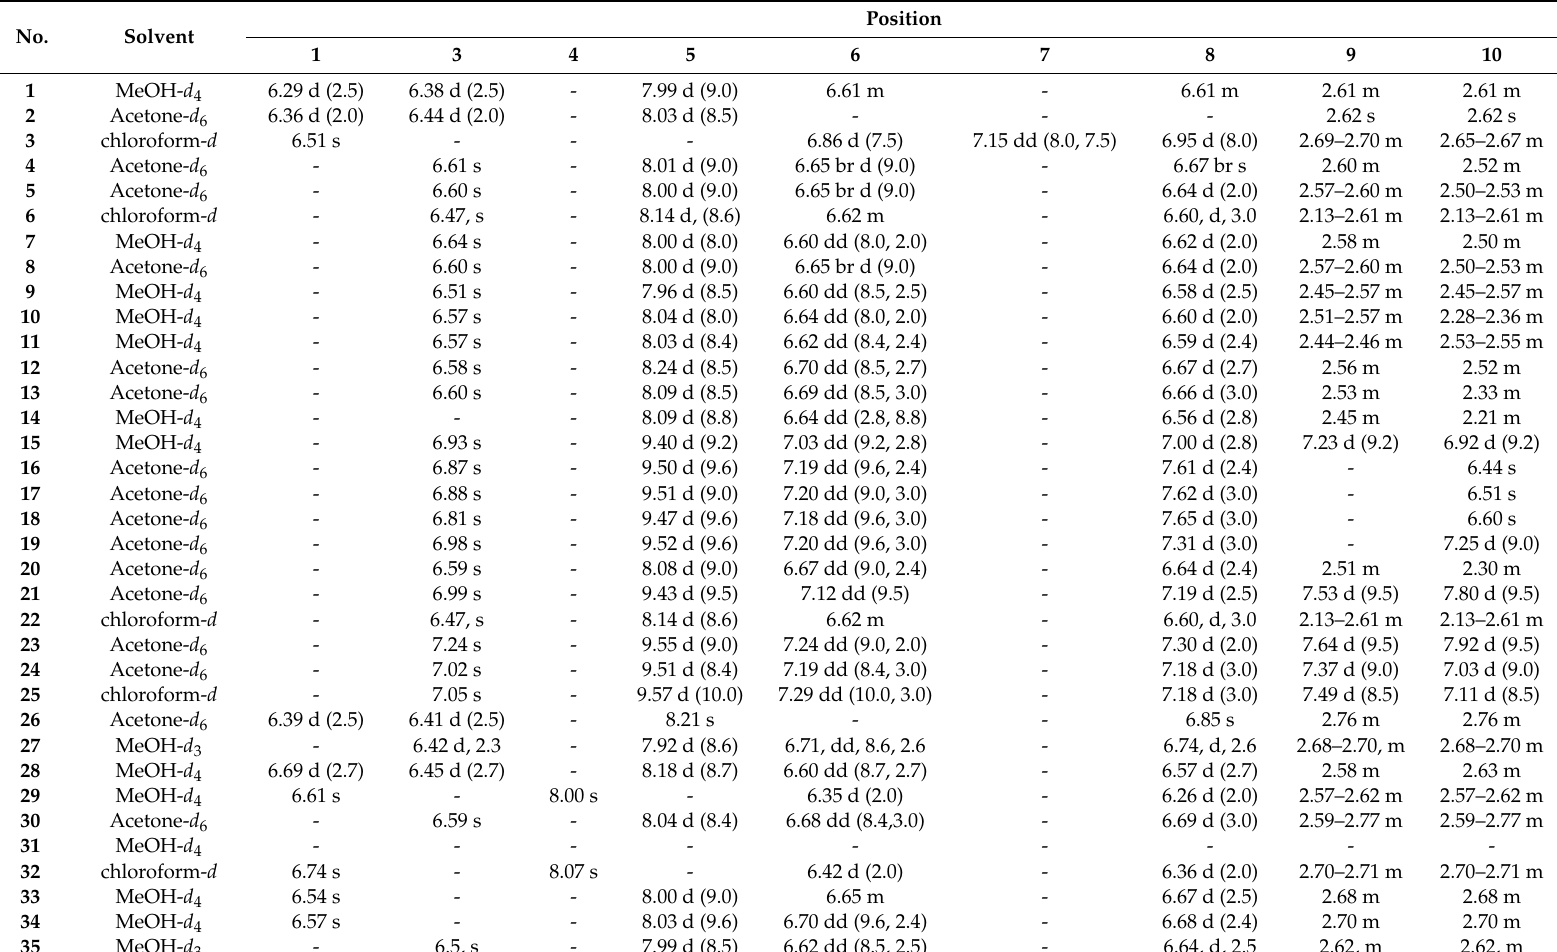
Table 3. 1 H NMR data of compounds 1 – 57